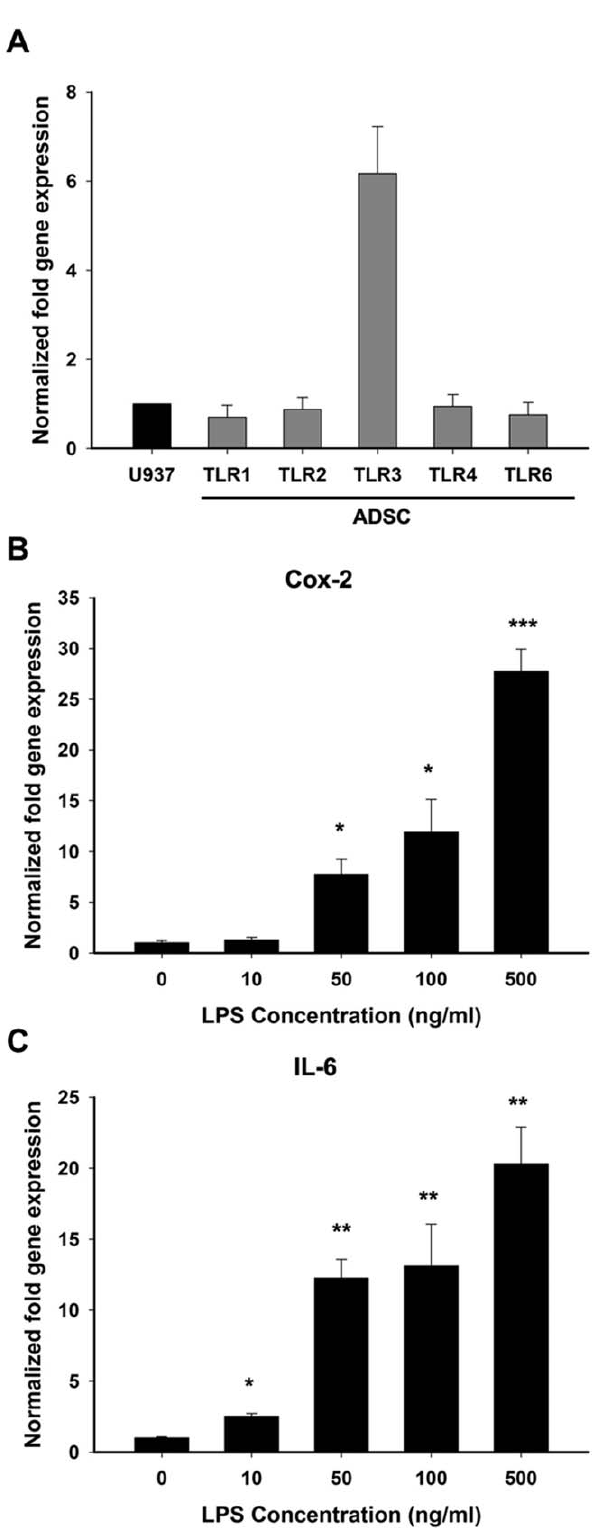
Figure 1. hADSCs expresses TLRs and stimulated by LPS. ( A ) The mRNA expression levels of all TLRs in the hADSCs were compared to the expression levels in U937 cells, as determined by real-time RT- PCR analysis; TLR3 showed a higher mRNA expression level in hADSCs than in U937 cells. ( B, C ) Determination of the optimal LPS treatment concentration by evaluating the expression of Cox-2 and IL-6